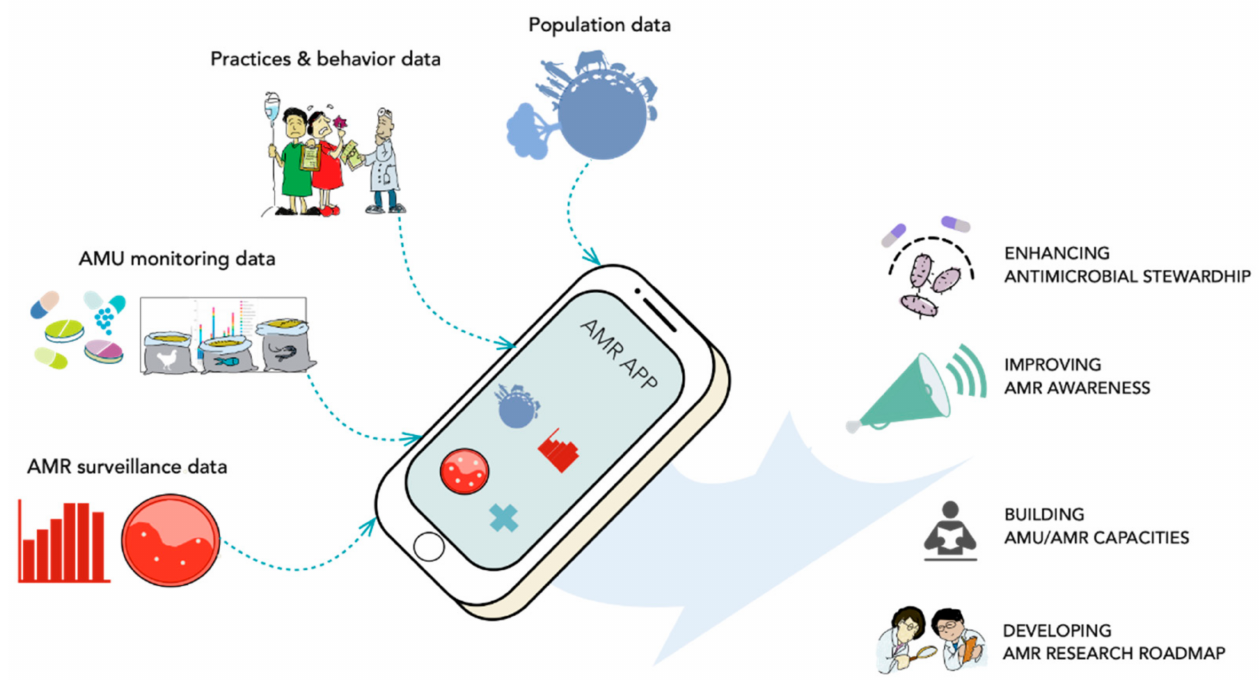
Figure 9. A sample schematic of the mobile-operated decision-support tool for antimicrobial stewardship and resistance control. (Images were adopted from Google